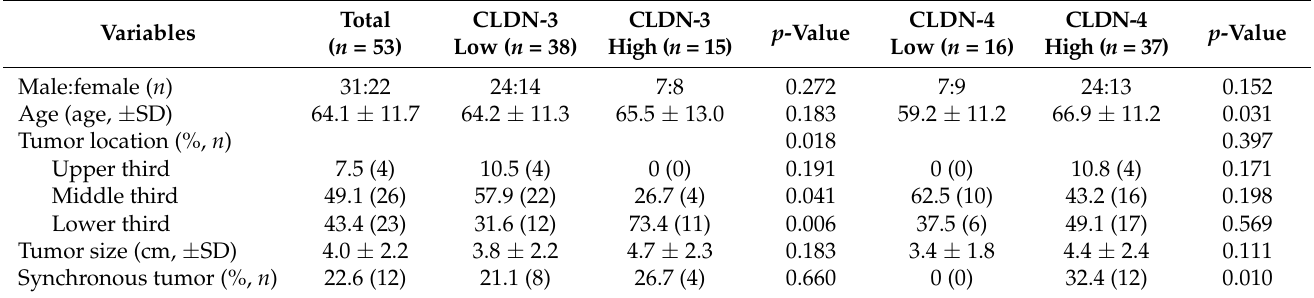
Table 1. Baseline clinical characteristics according to high and low expressions of CLDN-3 and CLDN-4.